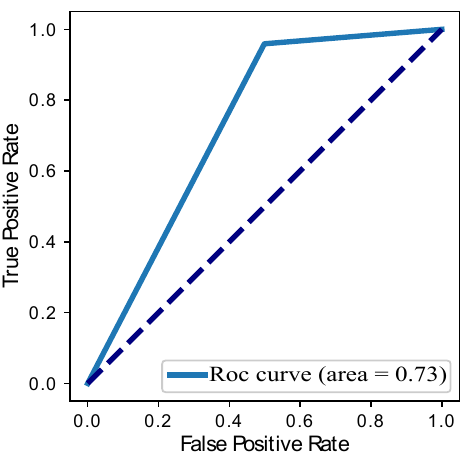
Figure 18. ROC curve of Logistic Regression (LR).